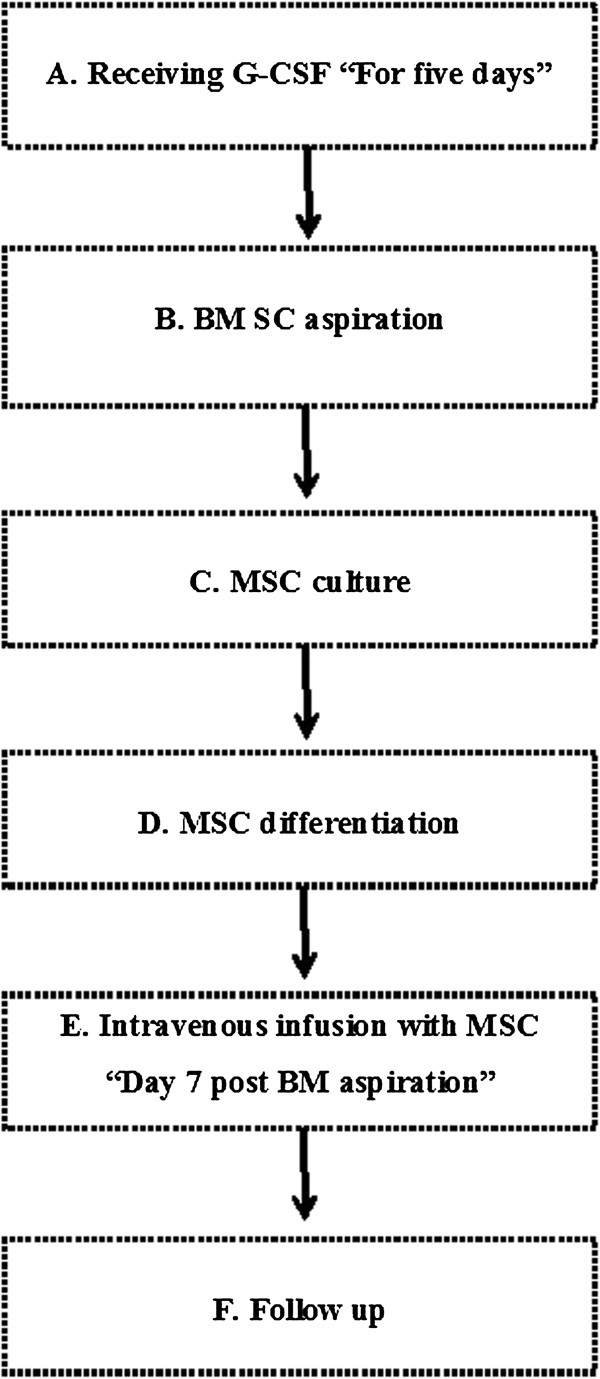
Work flow chart.